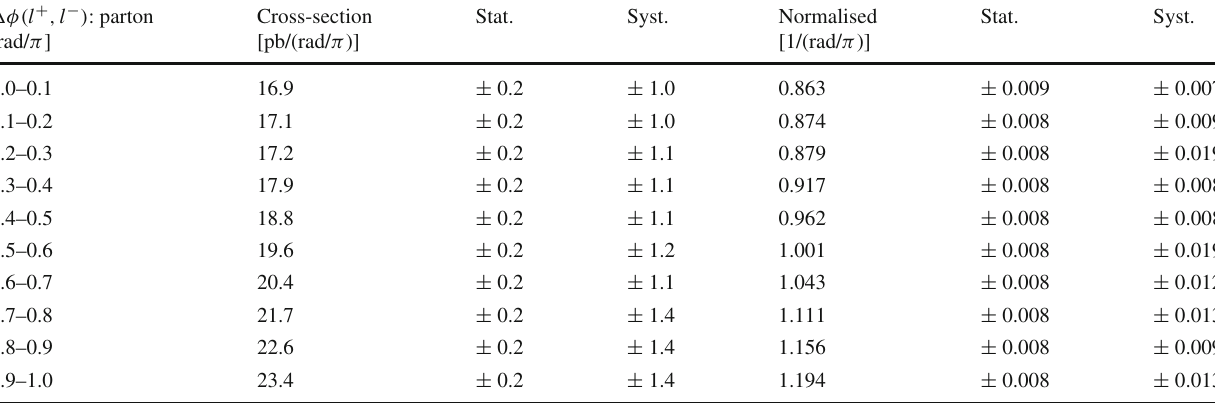
Table2 Summaryoftheparton-levelabsoluteandnormaliseddifferentialcross-sectionsasafunctionof (cid:3)φ((cid:13) + ,(cid:13) − ) ,withstatisticalandsystematic uncertainties in each